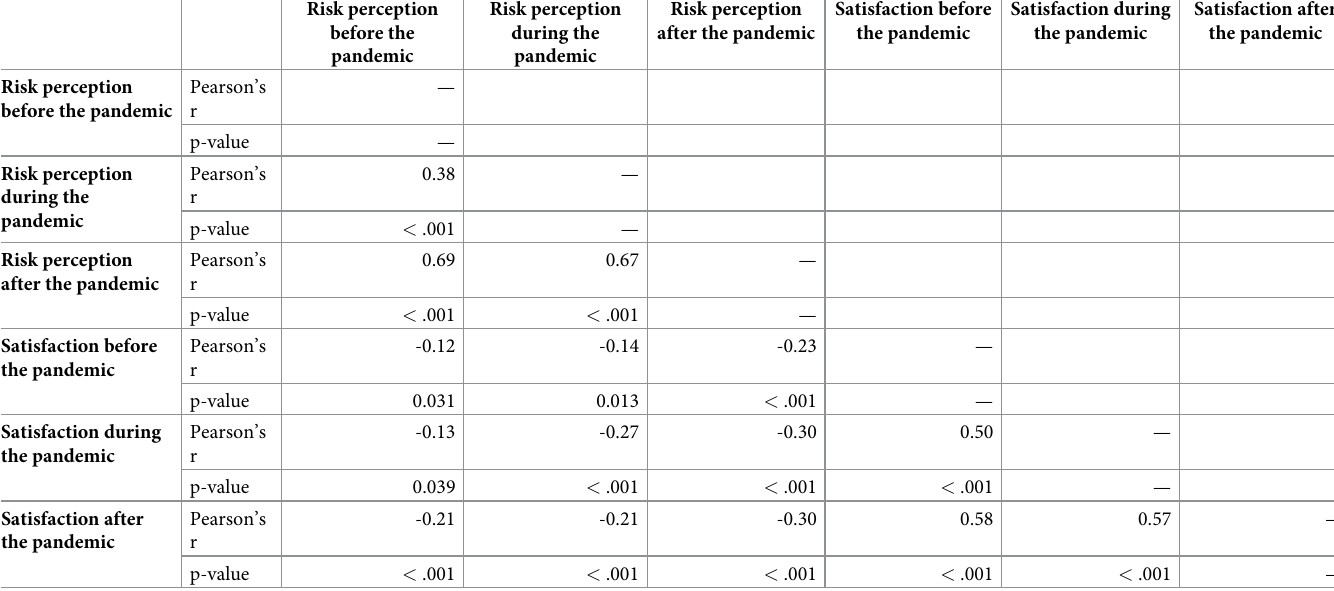
Table 11. Correlation matrix with Pearson’s correlations among risk-perception measures and STS satisfaction dimension over